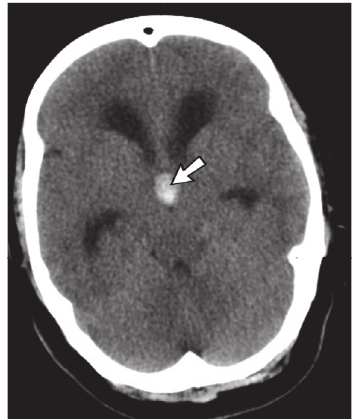
Figure 1: Axial noncontrast brain CT scan shows a hyperdense mass (arrow) at the location of interventricular foramen of Monro. Frontal and temporal horns of lateral ventricles are visible and enlarged.